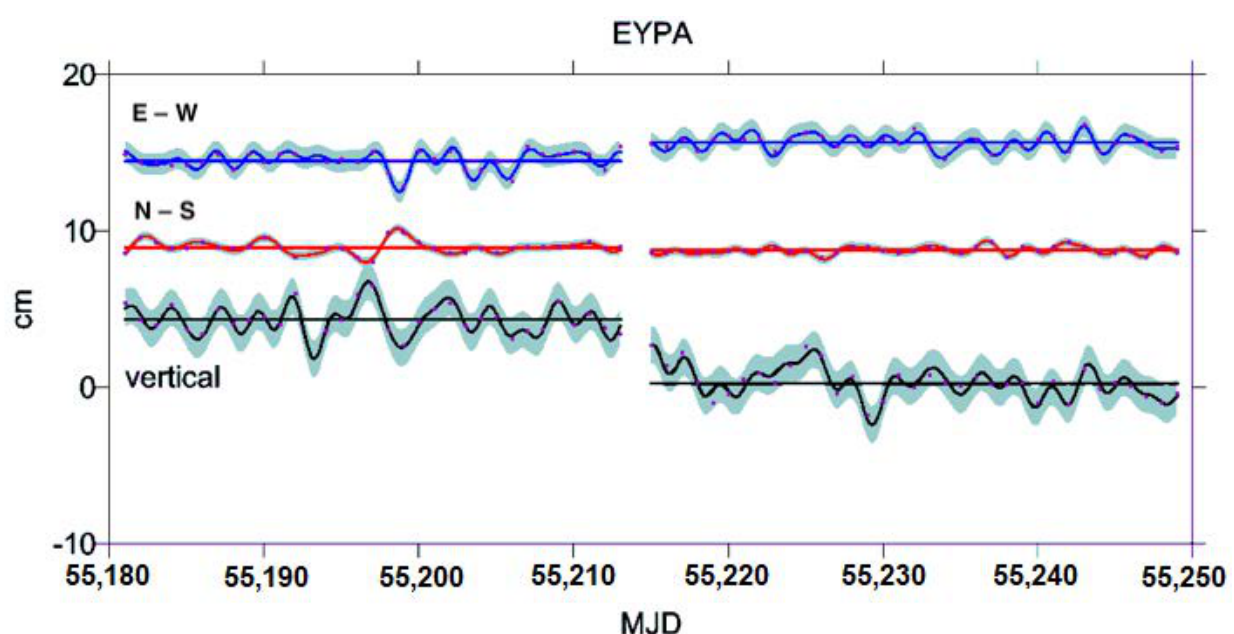
Figure 3. The systematic shift of EYPA station—coordinate differences expressed as the difference between the mean values before and after 18 January 2010. The error belt is from the PPP